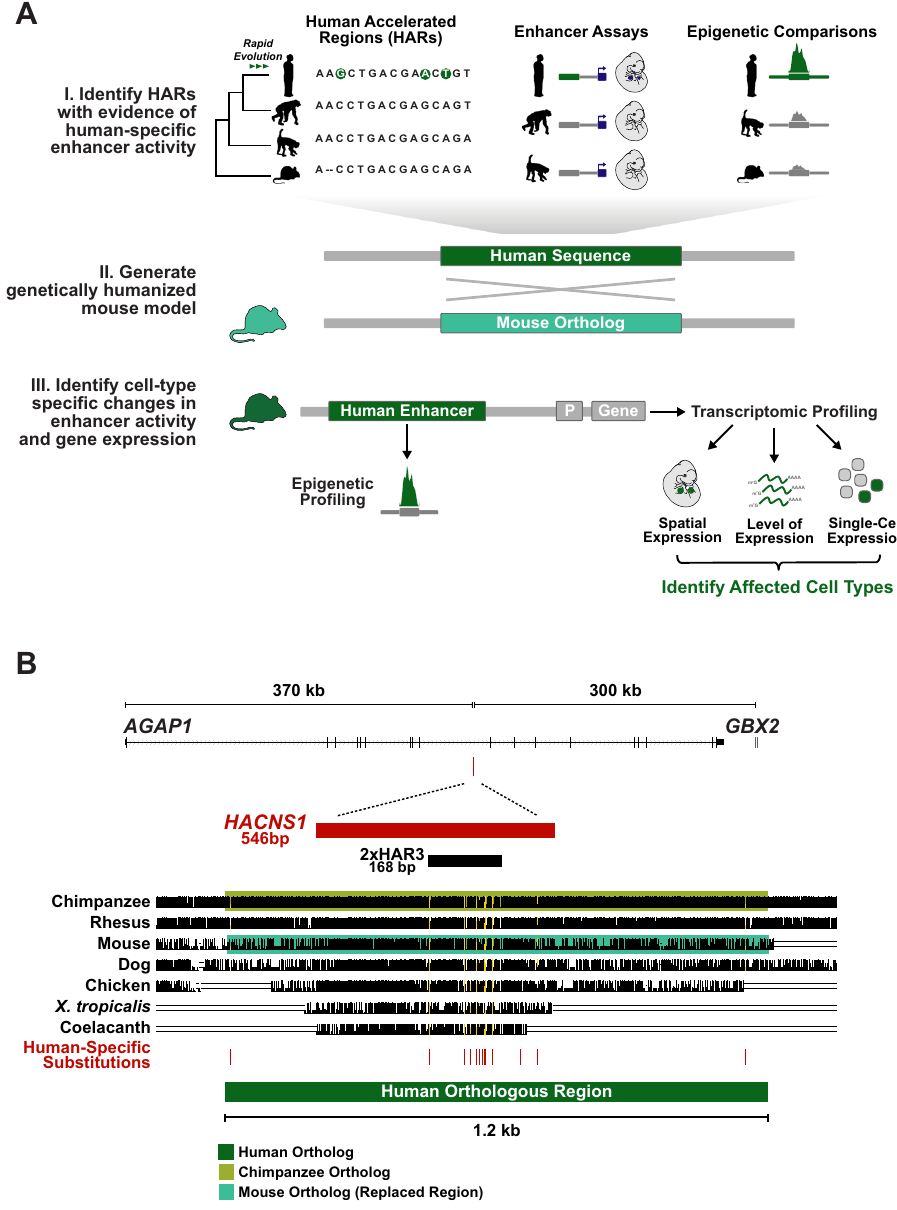
Fig. 1 Generating a knock-in mouse model for the Human Accelerated Region HACNS1 . A Schematic illustrating the generalized work fl ow we developed to characterize the gene regulatory functions of HARs with prior evidence of human-speci fi c enhancer activity, which we applied to HACNS1 in this study. B The location of HACNS1 in the human genome (GRCh37/hg19) relative to the nearby genes AGAP1 and GBX2 . Below, alignment of the human sequence used to generate the HACNS1 knock-in mouse with orthologous sequences from other vertebrate genomes, obtained from the UCSC hg19 100-way Multiz alignment (see Supplementary Data 1 for coordinates). The chimpanzee orthologous sequence used to generate the chimpanzee control line is highlighted in olive, and the mouse sequence replaced in each line is highlighted in teal. The location of each human-speci fi c substitution is indicated by a red line, and the corresponding positions in the alignment are highlighted in yellow. The locations of HACNS1 and 2xHAR3 are shown above the alignment 3,6